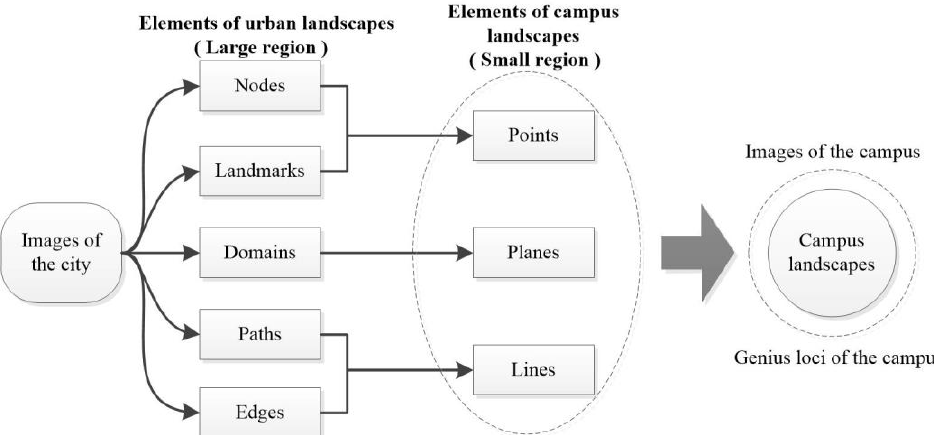
Figure 1. Theoretical framework of campus landscape analysis. This framework is derived from the theory of city images, but has been simplified by considering the characteristics of smaller research areas such as campuses. On this basis, the campus landscapes could be analyzed in order to support the exploration of campus images and campus genius loci.